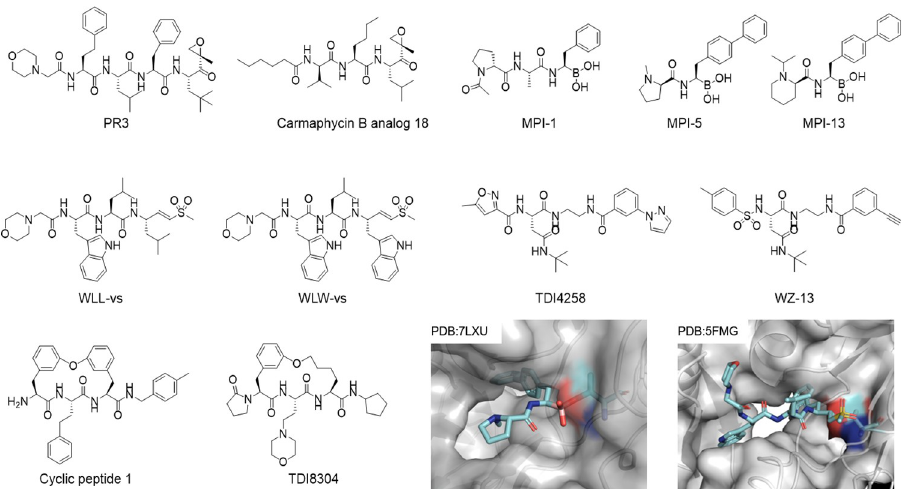
Fig 4. Pf20S-selective proteasome inhibitors. Inserted structures show binding of the MPI-5 to β 5 (PDB: 7LXU) and binding of WLW-vs binds to β 2 of the Pf20S (PDB: 5FMG).